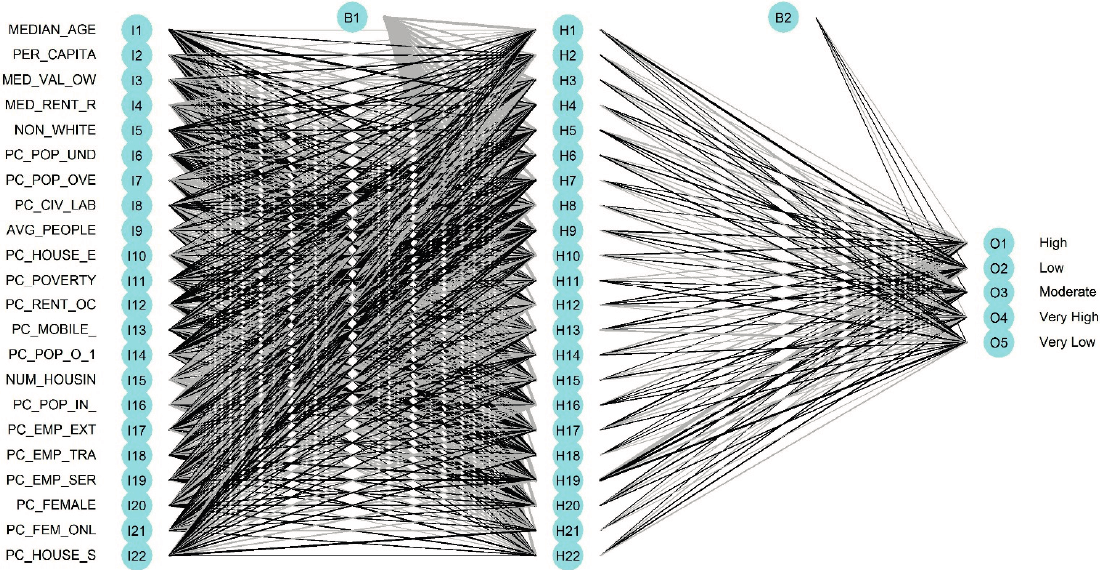
Figure 2. Structure of the neural network used to classify SoVI for Utah. The network contains 22 input nodes, 23 hidden nodes, and five output